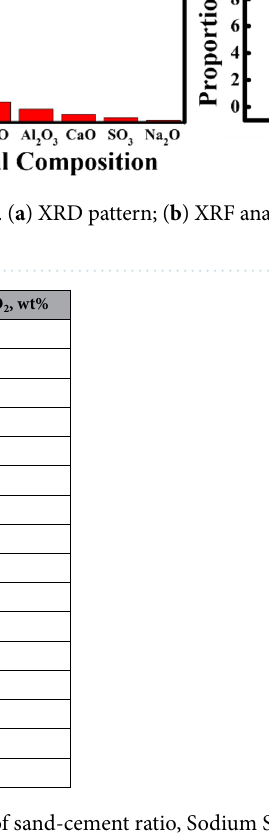
Table 1. Experimental scheme for the influence of sand-cement ratio, Sodium Silicate and CTAB to the